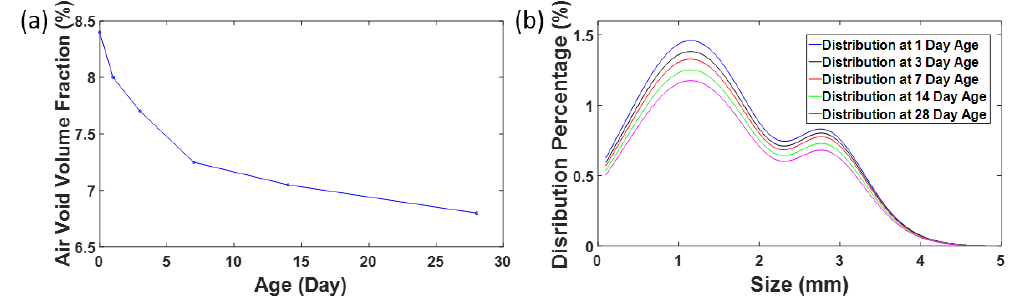
Figure 7. Air voids evolution for Sample Type 2. ( a ) The change of air void content with curing age measured with ultrasonic scattering (at early stages Day 1–28) and the ASTM C138 (Day 0); ( b ) Air void size distribution evolution with curing time.